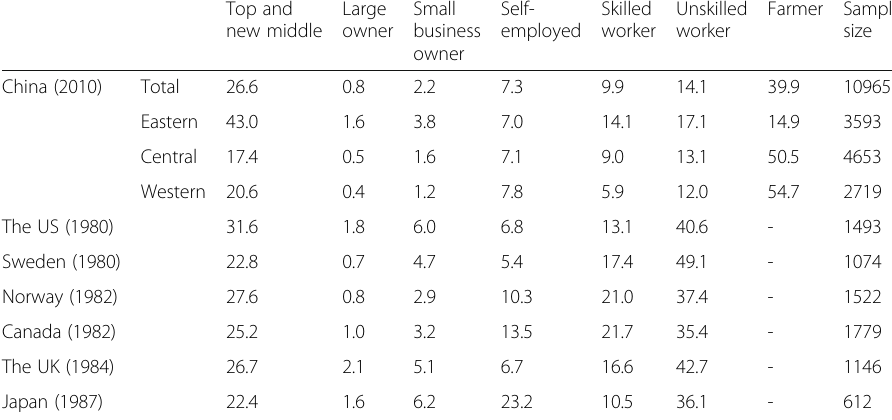
Table 7 Comparison of class structures in transitional China and developed countries(%)